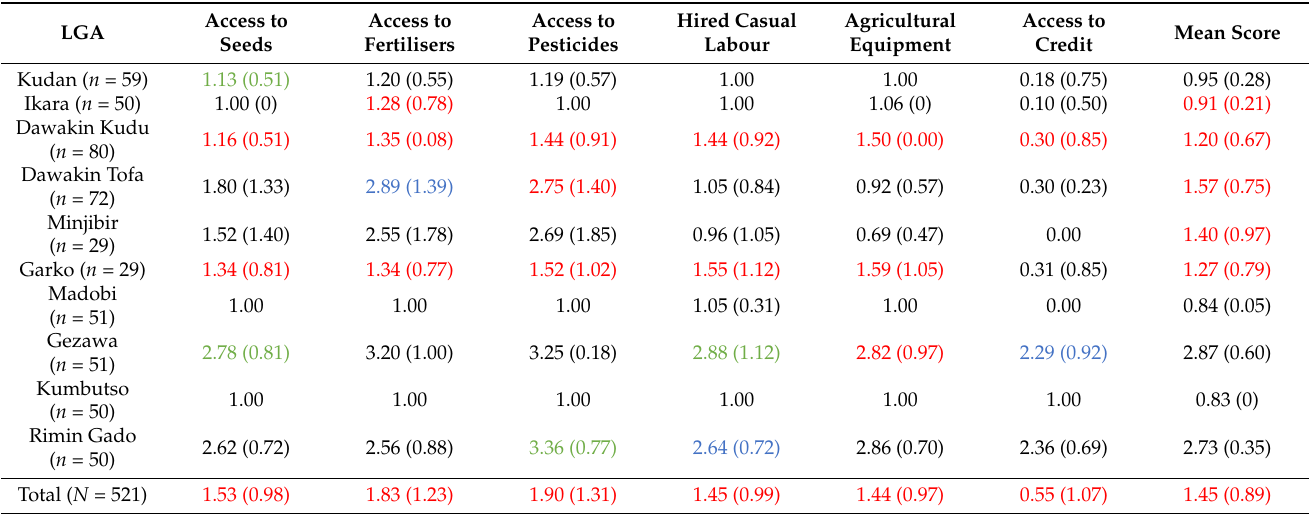
Table 5. Heat map of the scale of challenges experienced by farmers in accessing various inputs in vegetables production as a result of the COVID-19